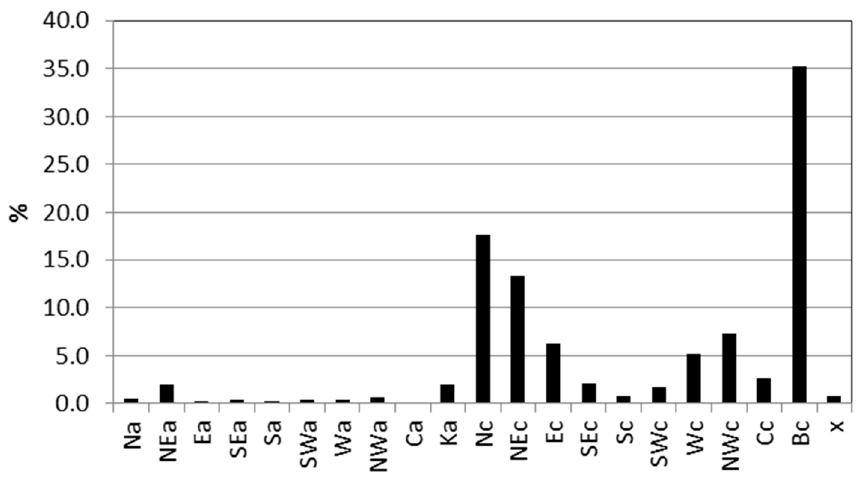
Figure 6. The annual maximum daily precipitation for different circulation types (1971–2014): 21 types of synoptic situations (circulation types, a—anticyclonic, c—cyclonic): Na, Nc—North, NEa, NEc—North–East; Ea, Ec—East, SEa, SEc—South–East, Sa, Sc—South, SWa, SWc—South–West, Wa, Wc—West, NWa, NWc—North–West, Ca—central anticyclone situation, Ka—anticyclonic wedge or ridge of high pressure, Cc—central cyclonic, center of low, Bc—through of low pressure (different directions of air flow and frontal system in the axis of through), x—unclassified situations or pressure col.